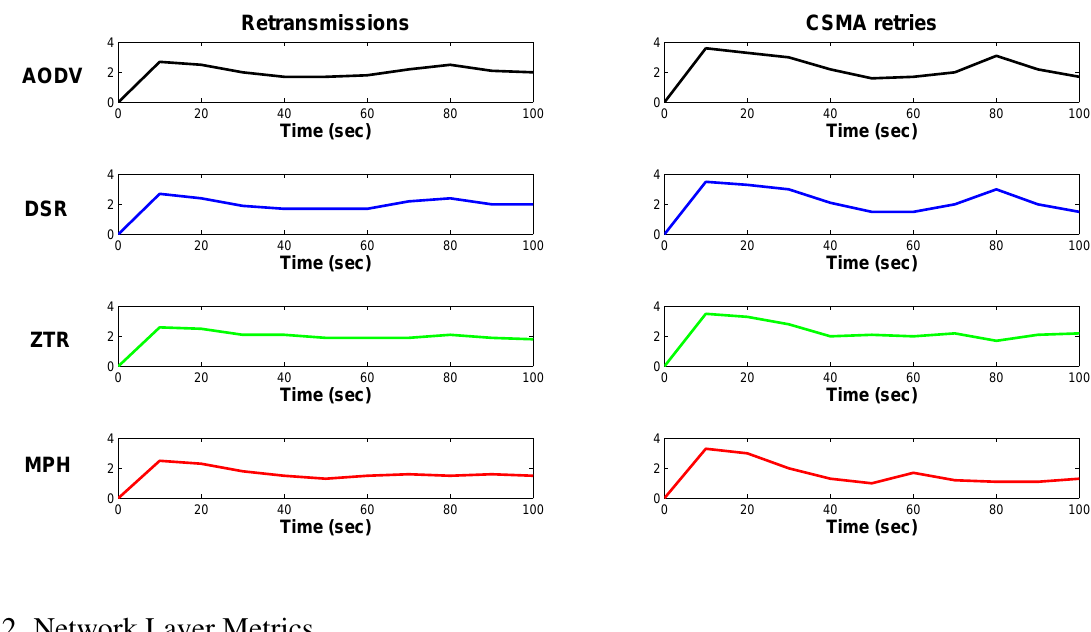
Figure 11. Average retransmissions and CSMA/CA retries vs. time